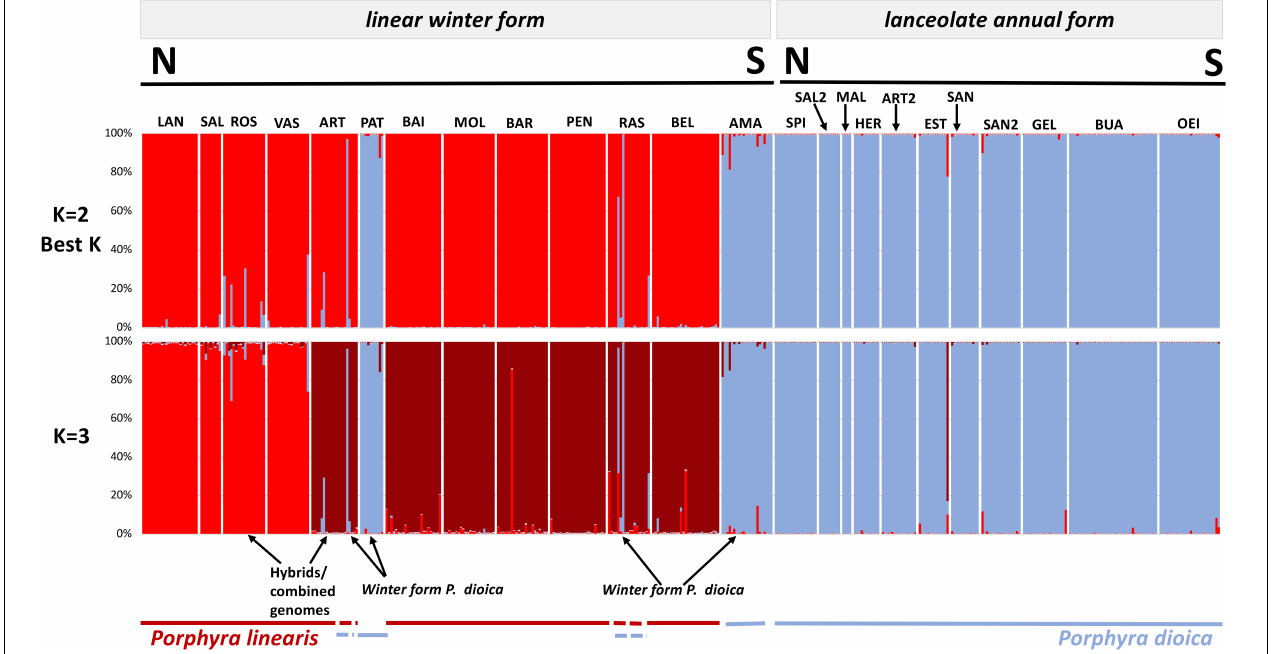
two shades of red), corresponding to North Central (Norway, Europe, Ireland, Britain, France and North Central Spain)